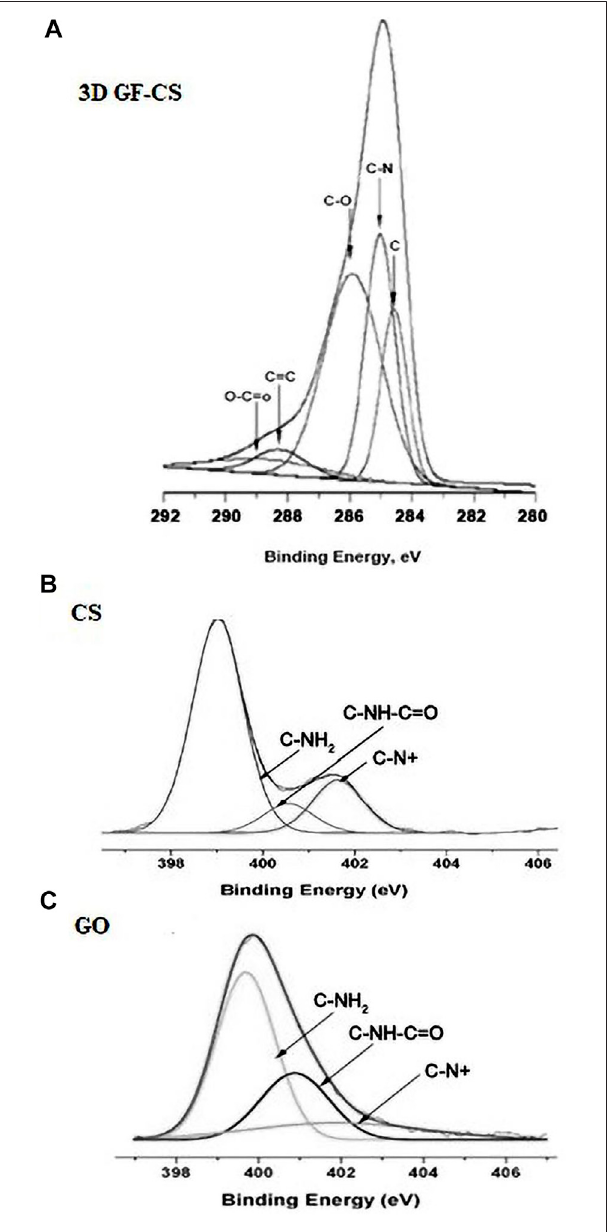
FIGURE 5 | Spectra of XPS of (A) 3DGF-CS, (B) CS, and (C) GO.